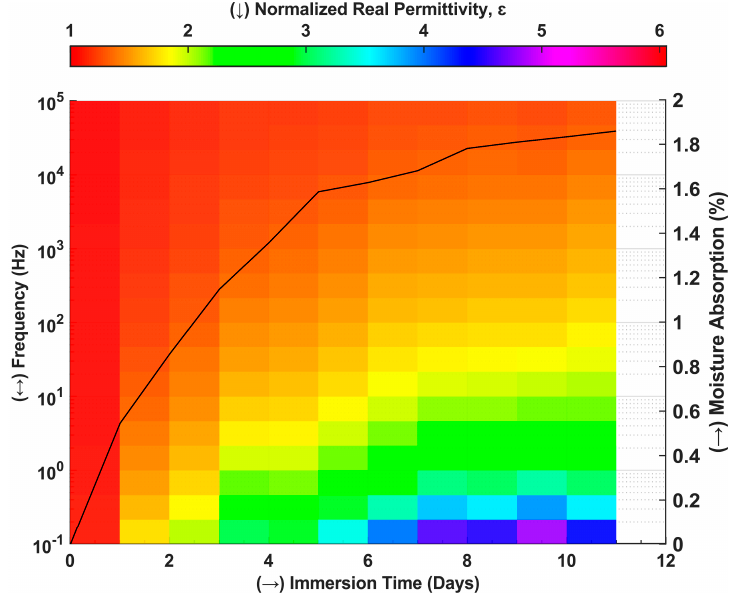
Figure 3. Heatmap of normalized real permittivity and trend of moisture absorption with immersion time [16].